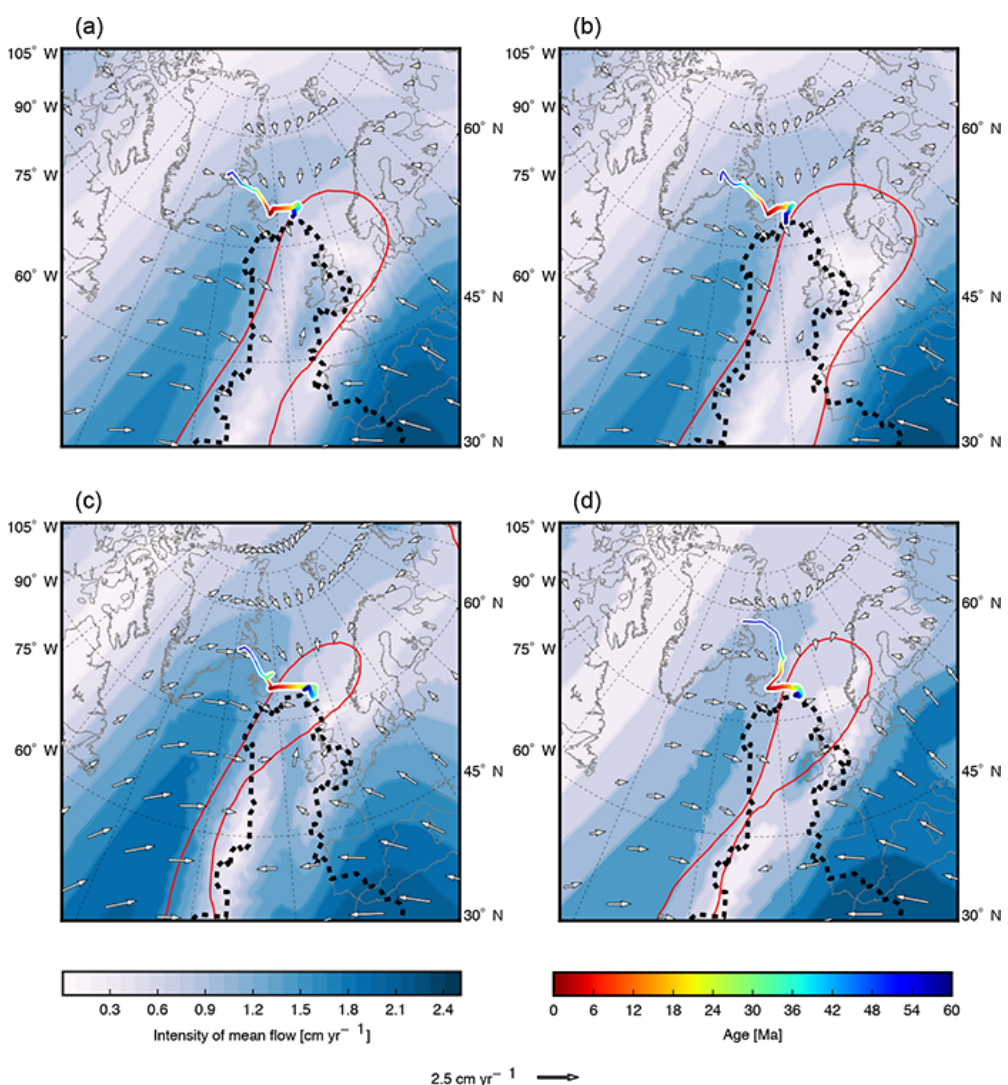
Figure 2. (a) In model case C1 (Table 2), the magnitude of mean flow velocity in a 300km thick shell above the CMB, time-averaged over the last 100Myr is shown in grey shading and associated flow directions are shown by white arrows. Flow directions are not shown for regions where flow magnitudes are smaller than their standard deviation, σ , to avoid visual clutter. The 75% chemical concentration isosurface of the dense chemical layer above the CMB, time-averaged over the last 100Myr, defines the mean location of model LLSVPs over the period. The red contour shows the mean location of the edges of the northern tip of model African LLSVP, 200km above the CMB. The black contour marks the region classified in four out of five tomography models to have a slower than average shear velocity in the lower mantle (Lekic et al., 2012). The thick multi-coloured trajectory shows the motion of the model plume in the mantle frame of reference since its arrival near the surface at 60Ma, while the thin multi-coloured trajectory shows corresponding motion in plate frame of reference – see in text for more details. (b–d) Same as in (a) , but for model cases C2–C4,